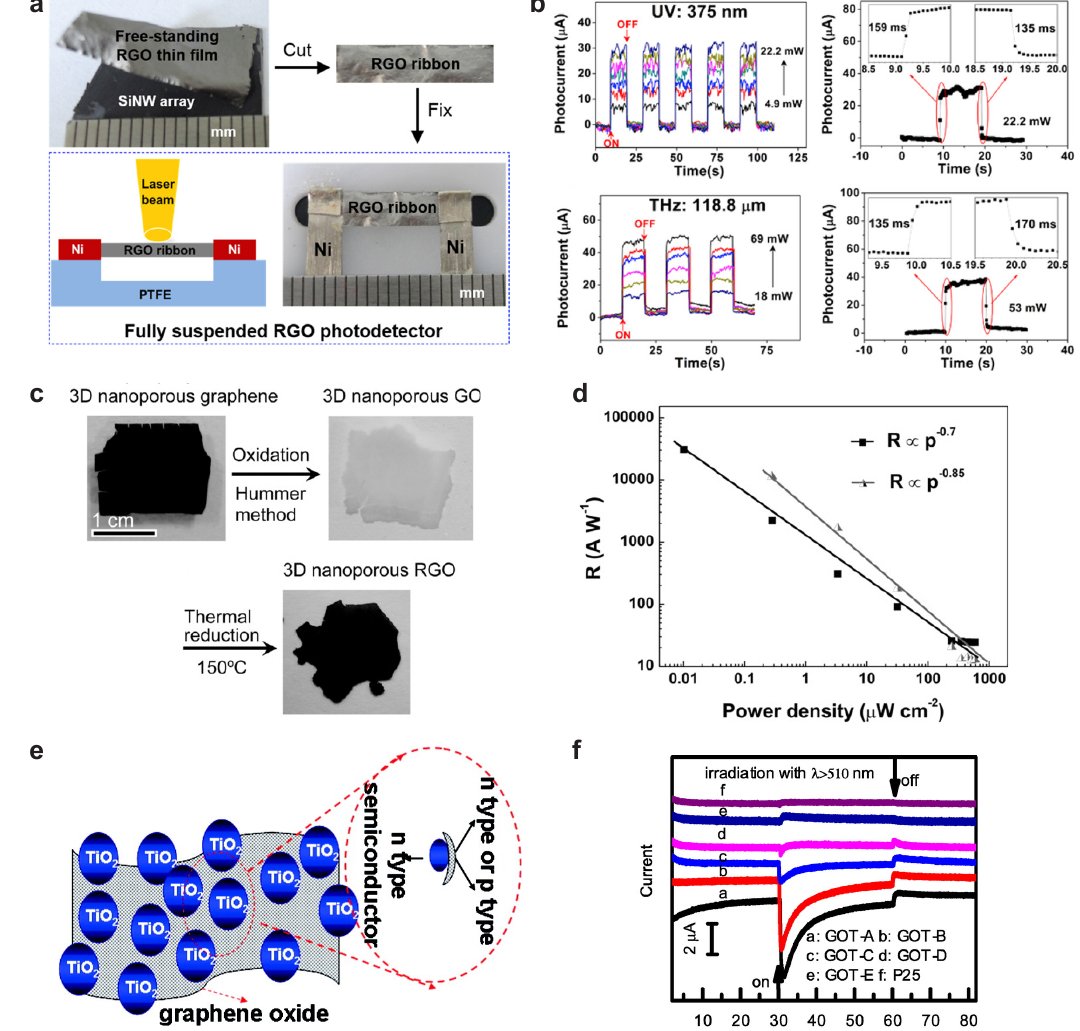
Figure 4. GO and rGO Photodetectors. ( a ) fully suspended rGO photodetector grown on Si